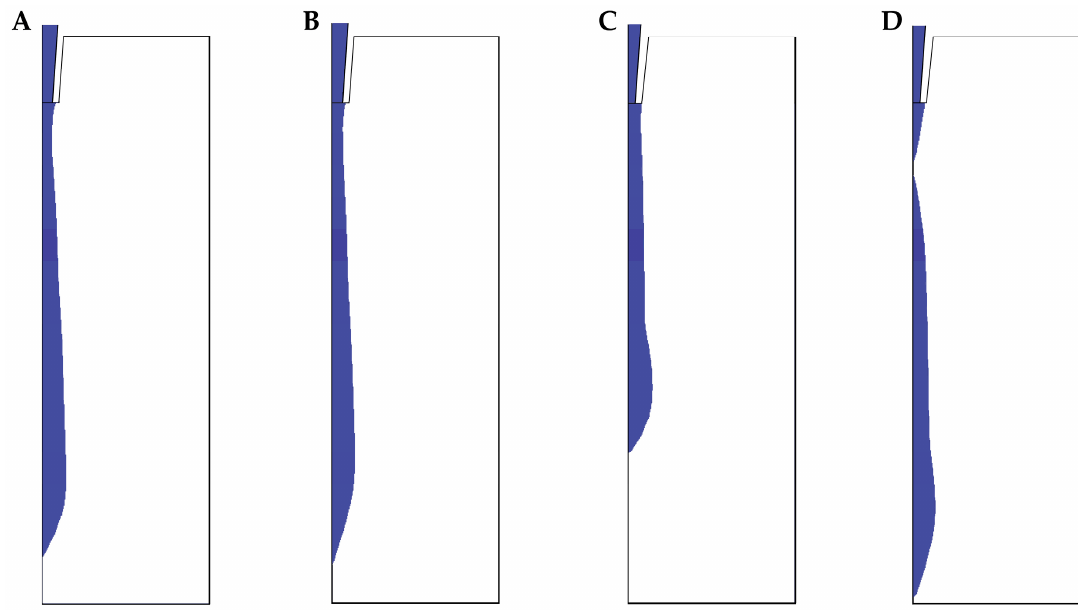
Figure 6. Volume fraction of Cellink Bioink. ( A ) 20G at 25 ◦ C in t = 3.14 s, ( B ) 20G at 37 ◦ C in t = 2.31 s, ( C ) 22G at 25 ◦ C in t = 10.00 s and ( D ) 22G at 37 ◦ C in t = 6.86 s. Blue color represents Cellink Bioink and white color represents the air.